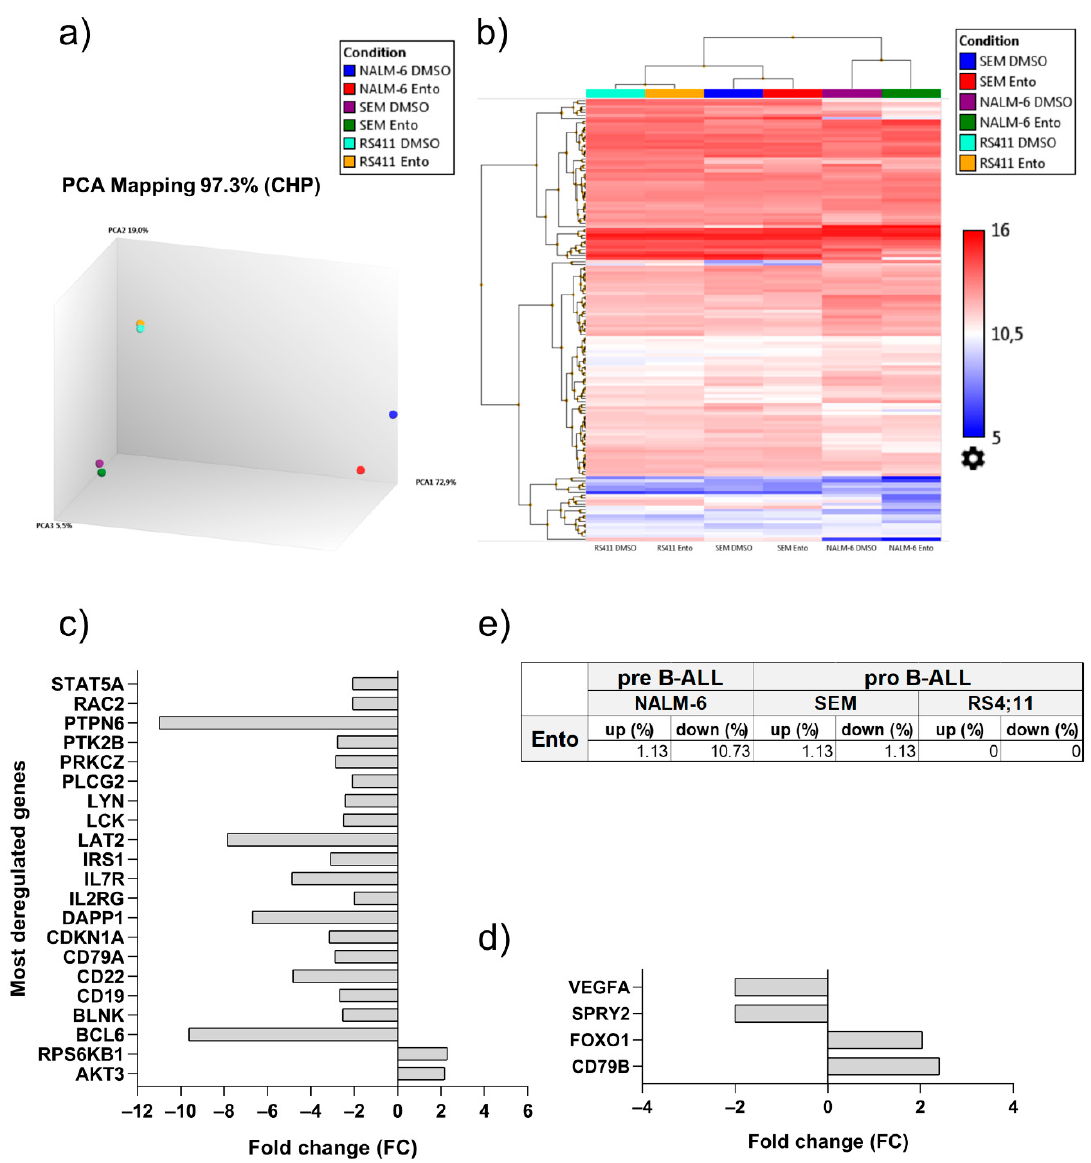
Figure 6. Entospletinib-induced gene expression changes in the B-ALL cell lines. Entospletinib-induced gene expression changes within the BCR and PI3K/AKT pathway predominantly in pre-B-ALL NALM-6 and slightly in pro-B-ALL SEM. ( a ) Principle component analysis of the control and 1 µ M Ento-exposed B-ALL cell lines revealed distinct clustering of the appropriate cell line samples and variance in the NALM-6 cells after Ento exposure. ( b ) Hierarchical clustering of all the relevant regulated genes demonstrates the gene expression changes in the B-ALL cell lines. ( c ) Fold changes of the significantly deregulated genes in NALM-6 and ( d ) SEM. ( e ) Percentagewise deregulation after 1 µ M Ento exposure.